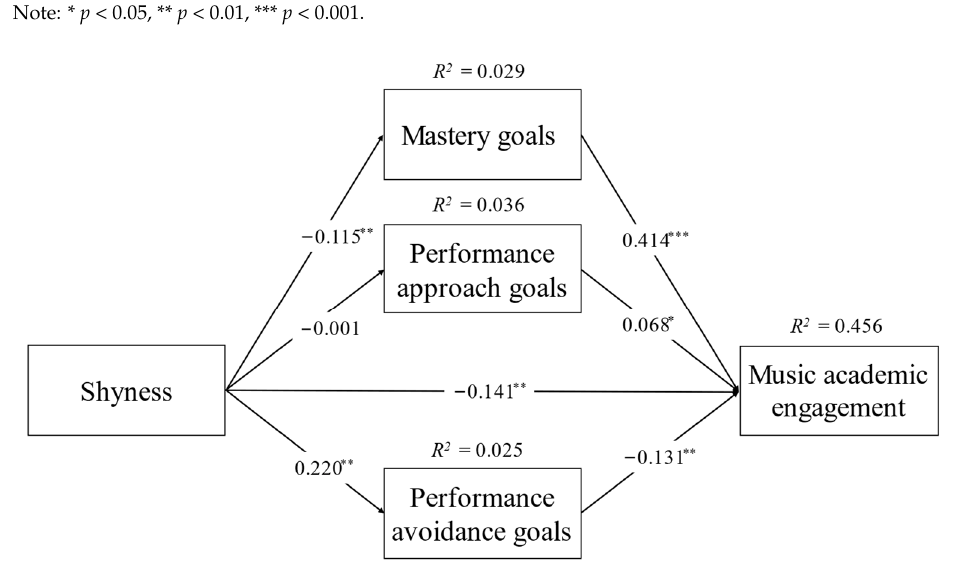
Figure 2. Mediation model of music achievement goals between shyness and music academic engagement. Note: * p < 0.05, ** p < 0.01, *** p <